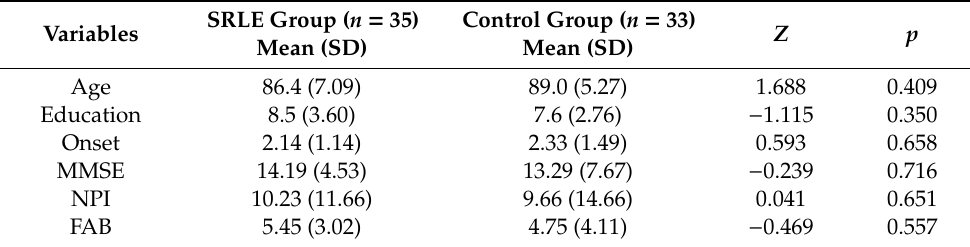
Table 1. Demographics of the participants ( n =